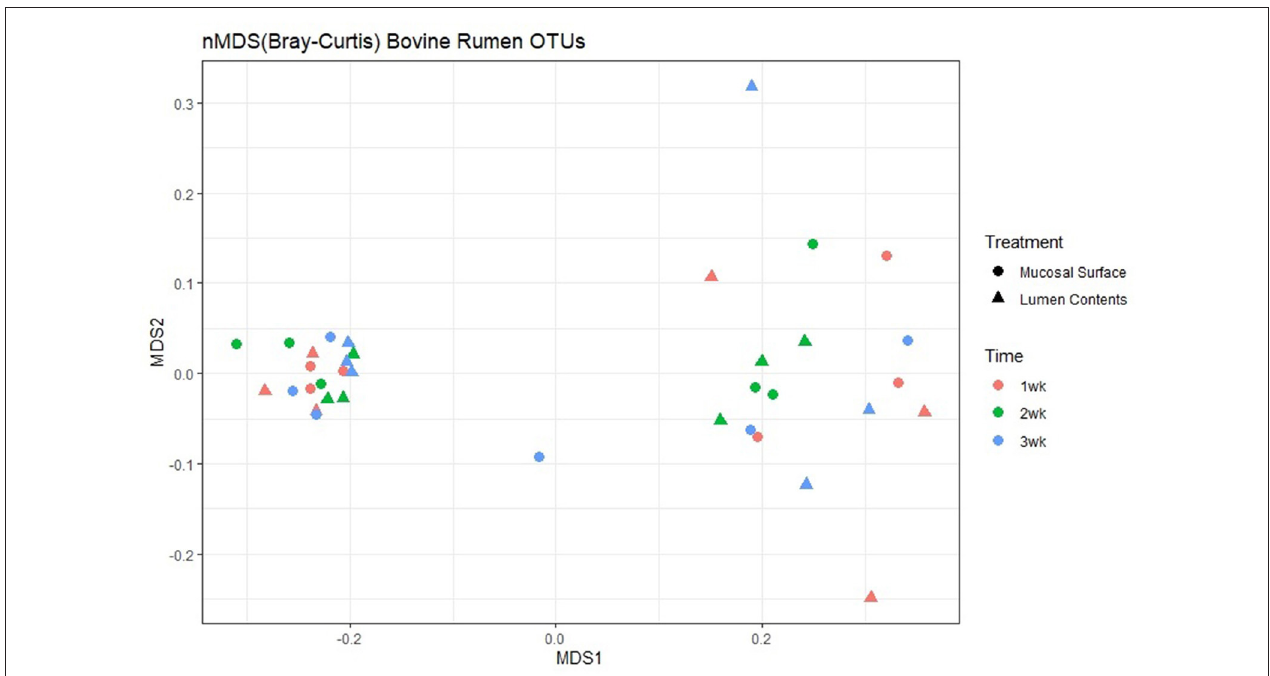
FIGURE 5 | Multidimensional scaling plot (MDS) of bacterial lineages in the mucosal surface (biopsy) and lumen contents by time.